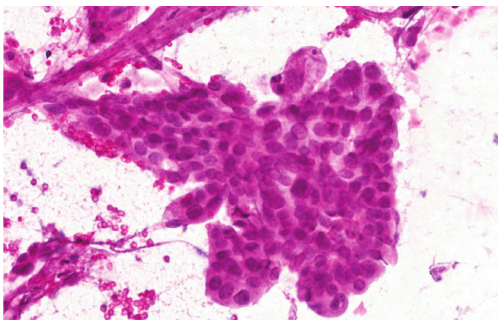
Figure 5: Microscopic image from FNA specimen. 40x—FNA prepared slide (smeared) at high power (Pap stain) showing a group of cells in a papillary arrangement with rounded borders. The cells have round to oval nuclei with slight pleomorphism and variably prominent